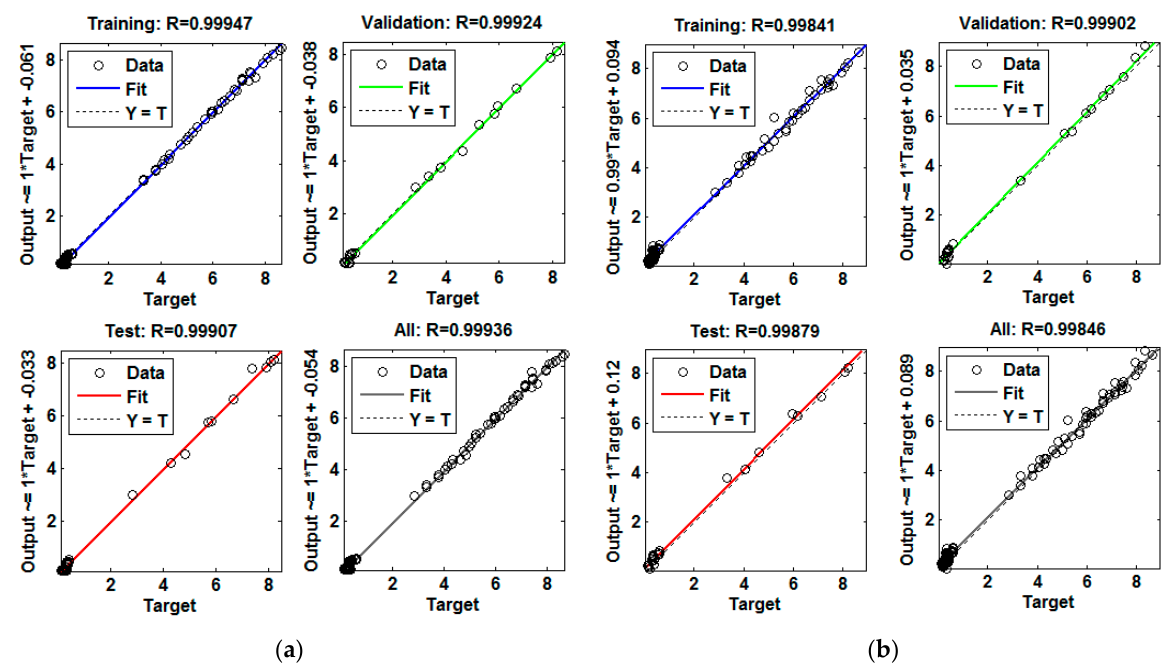
Figure 9. ANN model performance at the four stages for ( a ) single ( b ) double hidden layer.